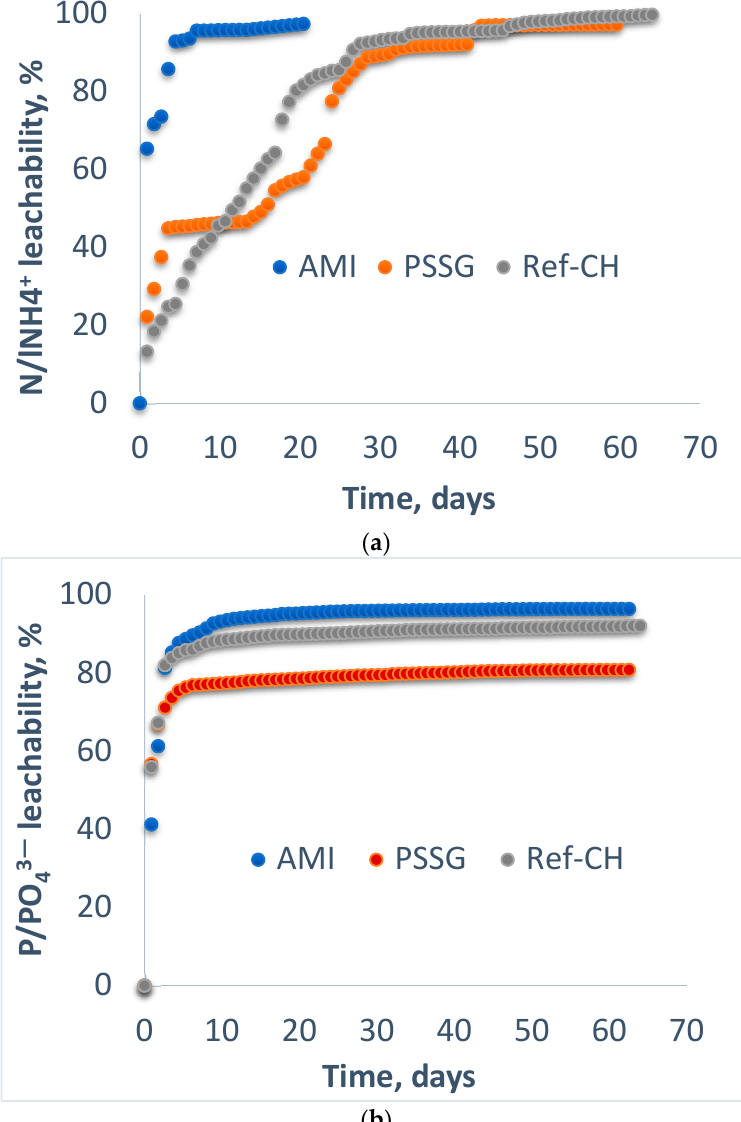
Figure 1. Leachability of ammonium nitrogen ( a ) and phosphorus ( b ) from fertilizers on sand col ‐ umn.